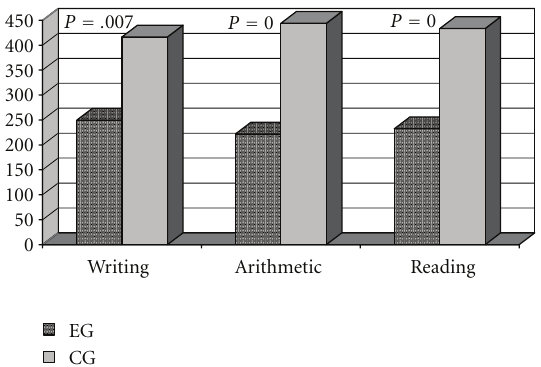
Figure 5: Comparison of EG and CG performances on the three subtests (writing, arithmetic, and reading) of the school perfor- mance